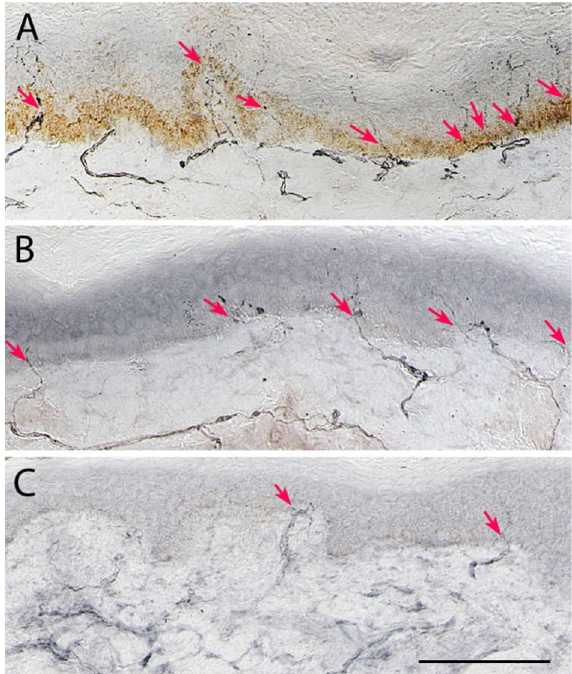
Figure 1. Representative images from skin biopsies from healthy control ( A ) and diabetes patient of similar age at baseline ( B ) and a follow-up visit after 6.5 years ( C ). Note numerous branching nerves reaching top layers of epidermis ( A ; red arrows) and sparse short single nerve and two dividing nerves (red arrows) in epidermis of the baseline biopsy ( B ) and more difficult to discern shorter nerves in the follow-up biopsy (red arrows). Scale bar for A–C = 100 µm.